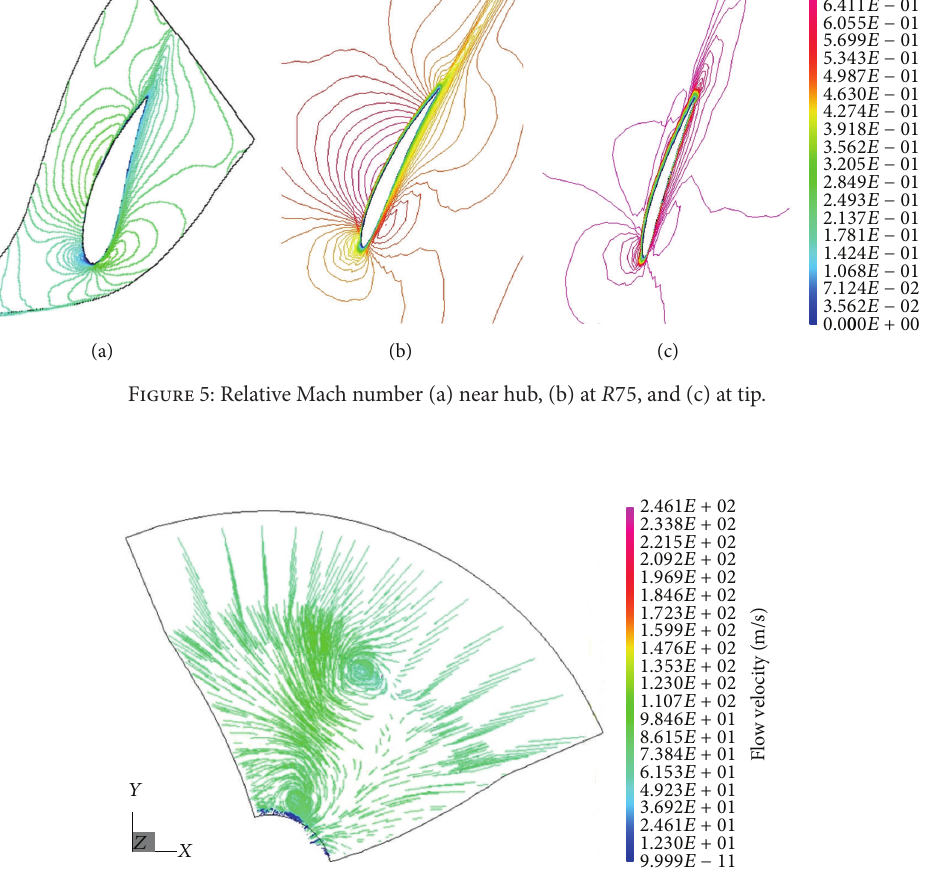
Figure 6: Counter-rotating vortex downstream of the rotor